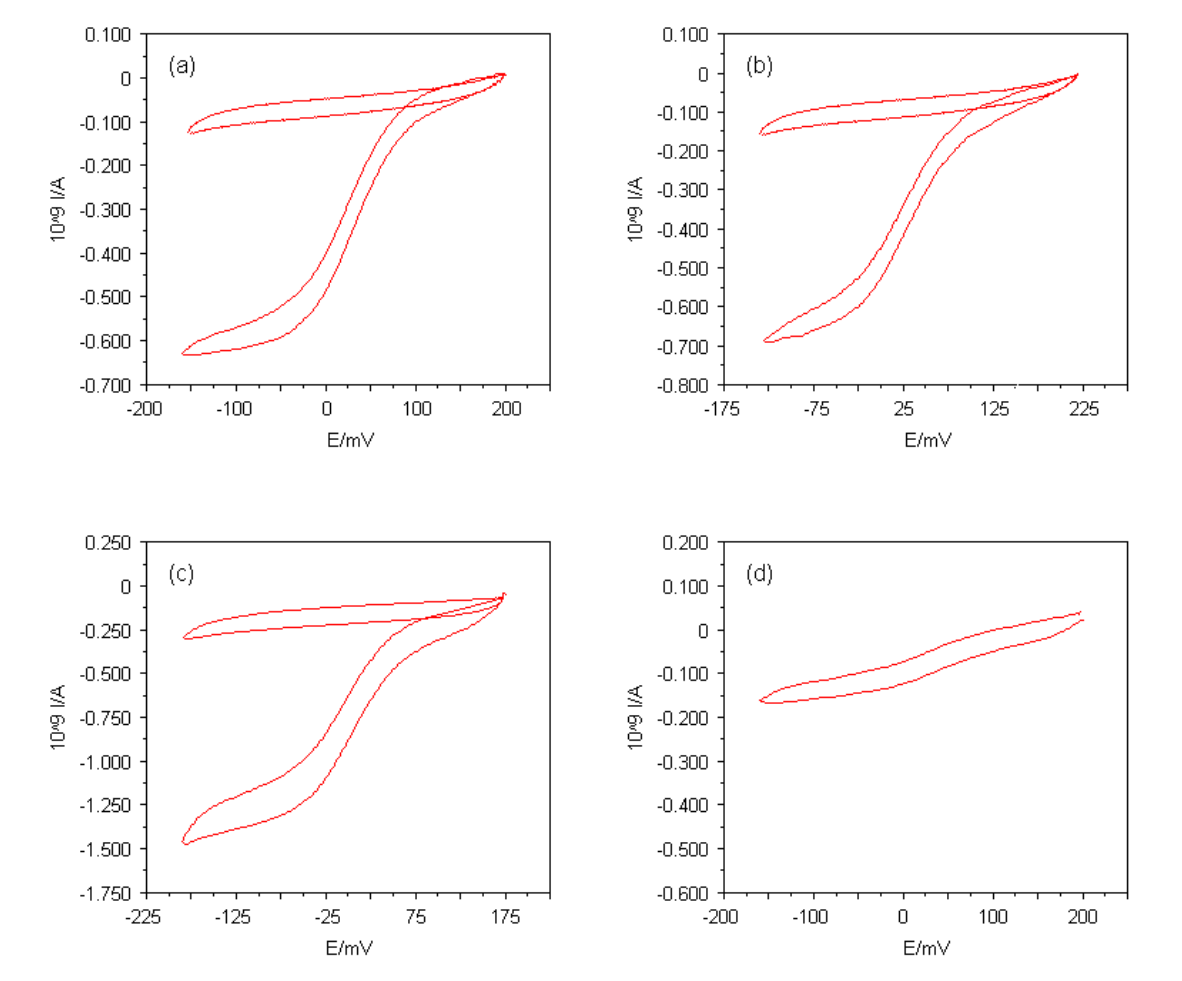
Figure 4. Cyclic voltammograms for reduction of (a) 50 µ M horse heart cytochrome c in the presence of 16 µ M 4,4'-bipyridyl disulphide, (b) 50 µ M horse heart cytochrome c in the presence of 16 µ M L-cysteine, (c) 55 µ M amicyanin from Thiobacillus versutus in the presence of 10 µ M L-cystine dimethyl ester dihydrochloride and (d) 4.8 µ M horse heart cytochrome c in the presence of 20 µ M 4,4'-bipyridyl disulphide at Multi MEAs with 5 µ m in diameter. The supporting electrolyte consisted of 5mM sodium phosphate buffer (pH 7.0) and 100mM NaCl, the potential scan rate used was 20mVs -1 . The cyclic voltammograms recorded in the buffer solutions alone are also